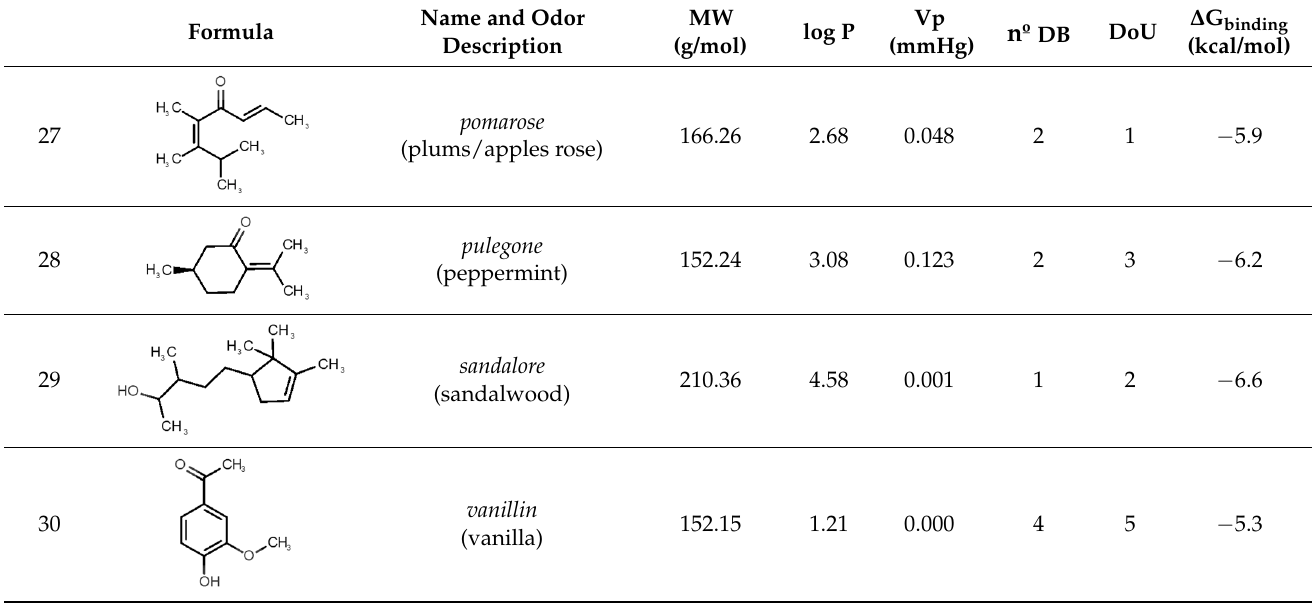
Table 2. Description of unpleasant odorant molecules under study, according to physicochemical and structural charac- teristics.